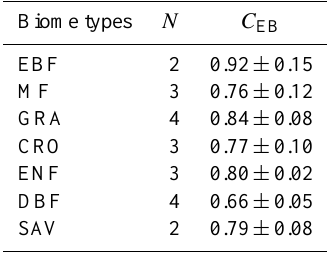
Table 5. The mean and standard deviation of monthly midday (13:30LT) surface energy balance closure ( C EB ) of different biome types for the 21 (out of 30) FLUXNET sites ( N ) under study. Nine out of 30 sites had missing ground heat flux. C EB is computed ac- cording to Stoy et al. (2013).